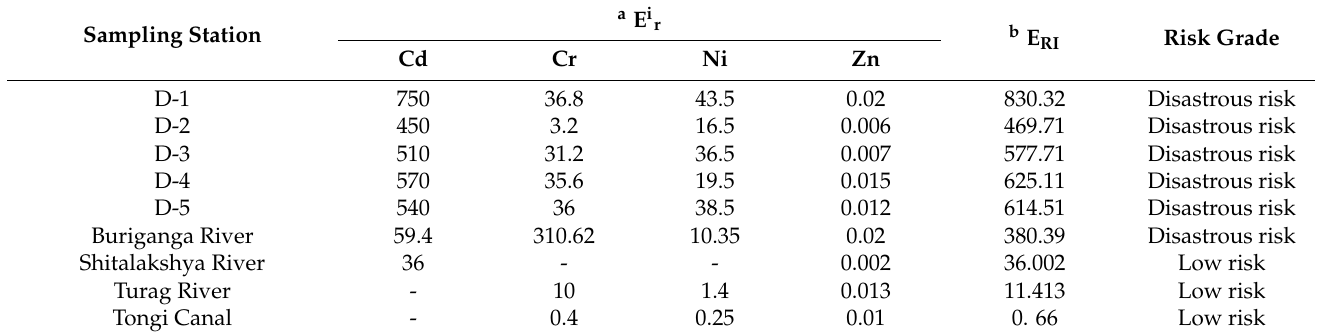
Table 7. Ecological risk characterization of the Peripheral Rivers in Dhaka